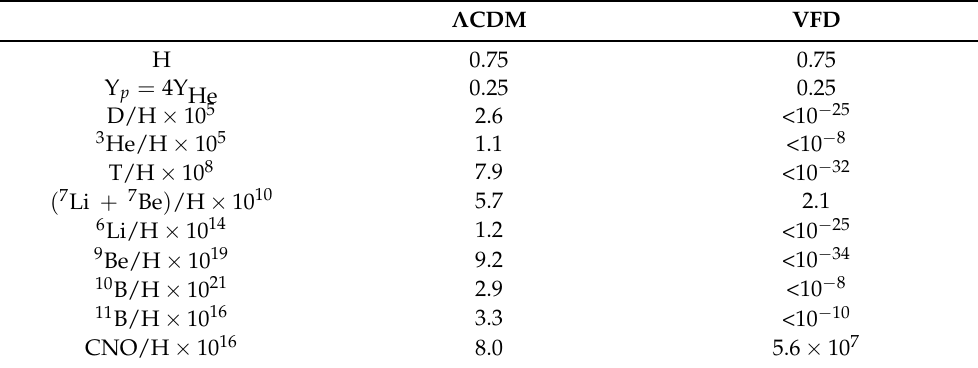
Figure 3. Dependencies of relative abundances of neutron and 4 He on cosmic time dt = ad η are given by red and blue curves, respectively, ( a ) for standard cosmological model, ( b ) for the VFD model. Table 1. Final abundances of light elements in the Λ CDM model at Ω b = 0.049 and the VFD model at Ω b =